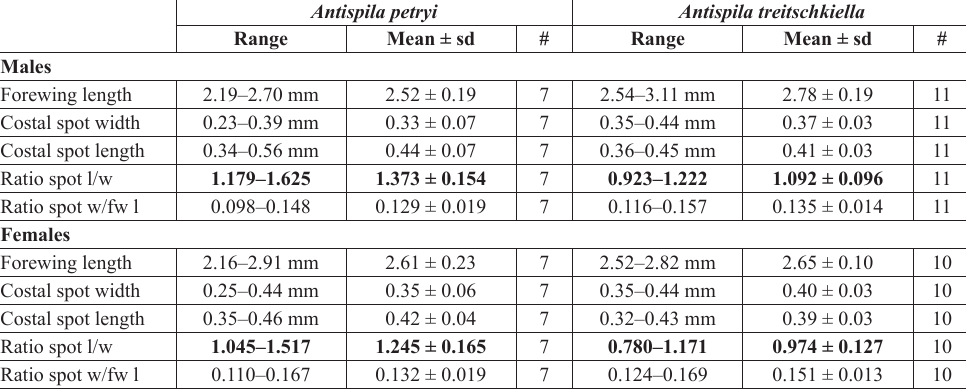
Table 2. Comparison of measurements of forewing and costal spot in Antispila petryi and A. treitschkiella males and females. Measured on photos, specimens from RMNH collection. Forewing length here does not include fringe, and thus differs from measurements in descriptions. The ratio length–width of the costal spot differs significantly between the species (marked in bold), but still shows an